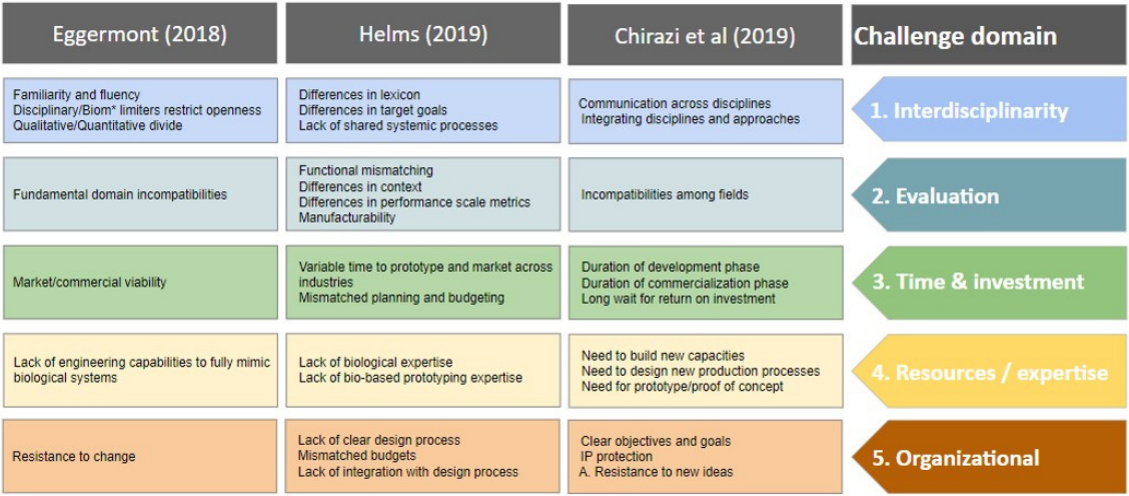
Figure 2. Integrative challenge domain model of industry/biom* challenges [48,61,62].